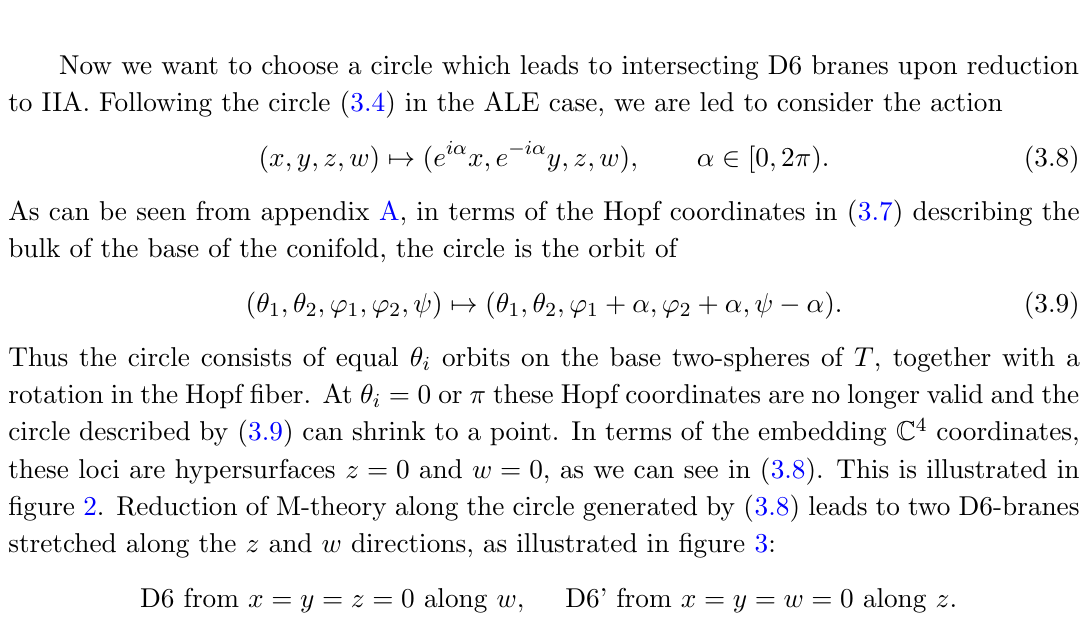
Figure 2. Each axis represents the modulus of a complex number, the surrounding circles denote its phase. We will reduce on the red (solid) circles, corresponding to the phase of x and y , which shrink to a point at the z and w